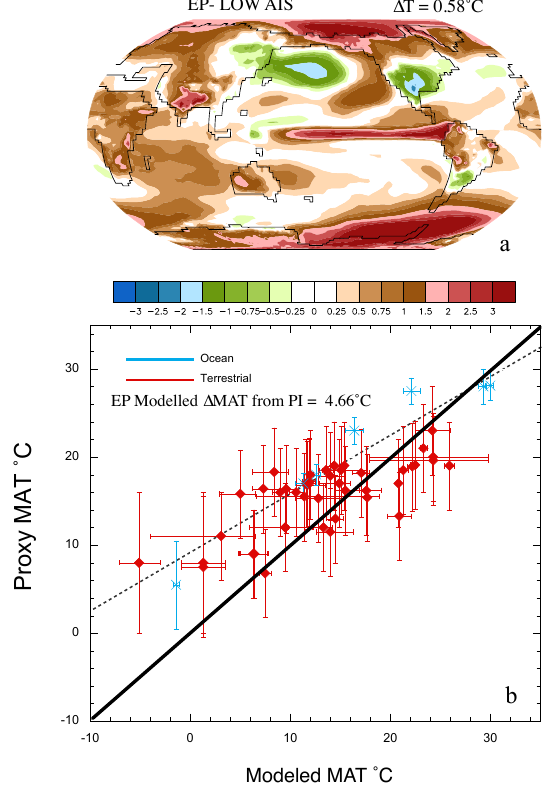
Fig. 5. (a) Modeled temperature anomaly for the EP simulation mi- nus the LOW AIS simulation ( ◦ C), (b) pointwise EP case global mean MAT compared against the proxy record MAT ( ◦ C). These Figure 3. a) Modelled temperature anomaly for the EP simulation minus the LOW AIS simulation (˚C), b) are the same terrestrial and SST records and error bars described in Pointwise EP case global mean MAT compared against the proxy record MAT (˚C). These are the same terrestrial and SST records and error bars described in Figure 1. The best fit line (black dashed) is Fig. 1. The best fit line (black dashed) is weighted to include error weighted to include error uncertainty is fitted across all points and the y-intercept and slope reported in uncertainty and is fitted across all points and the y intercept and slope reported in Table